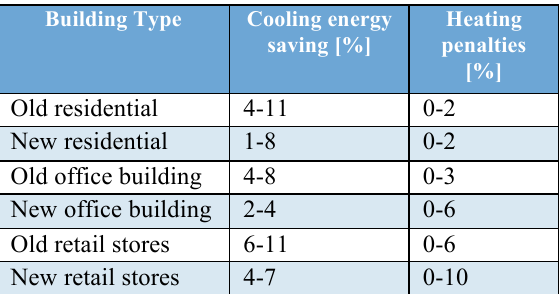
Tab. 2. Summary of performance of cool roofs based on simulation-based studies (Testa,